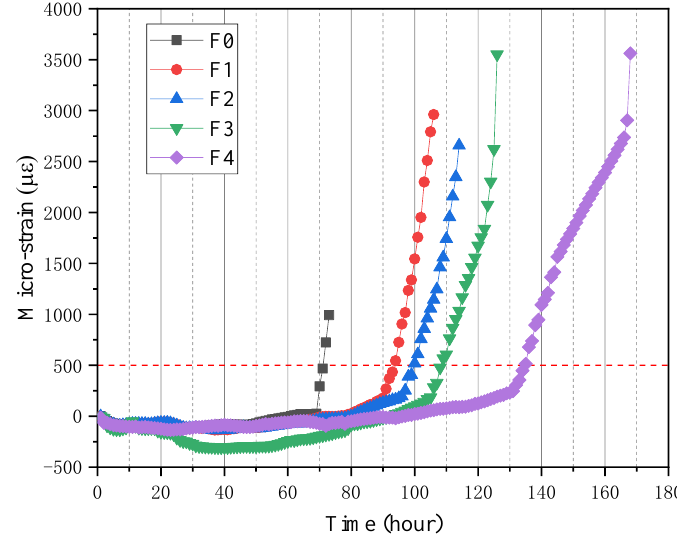
Figure 11. Micro-strain of 50% content FA specimen.